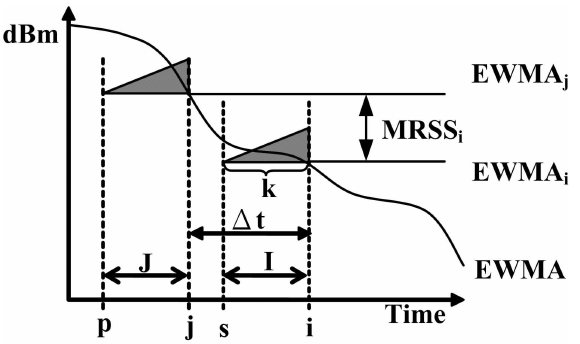
Figure 1. The MRSS calculation.